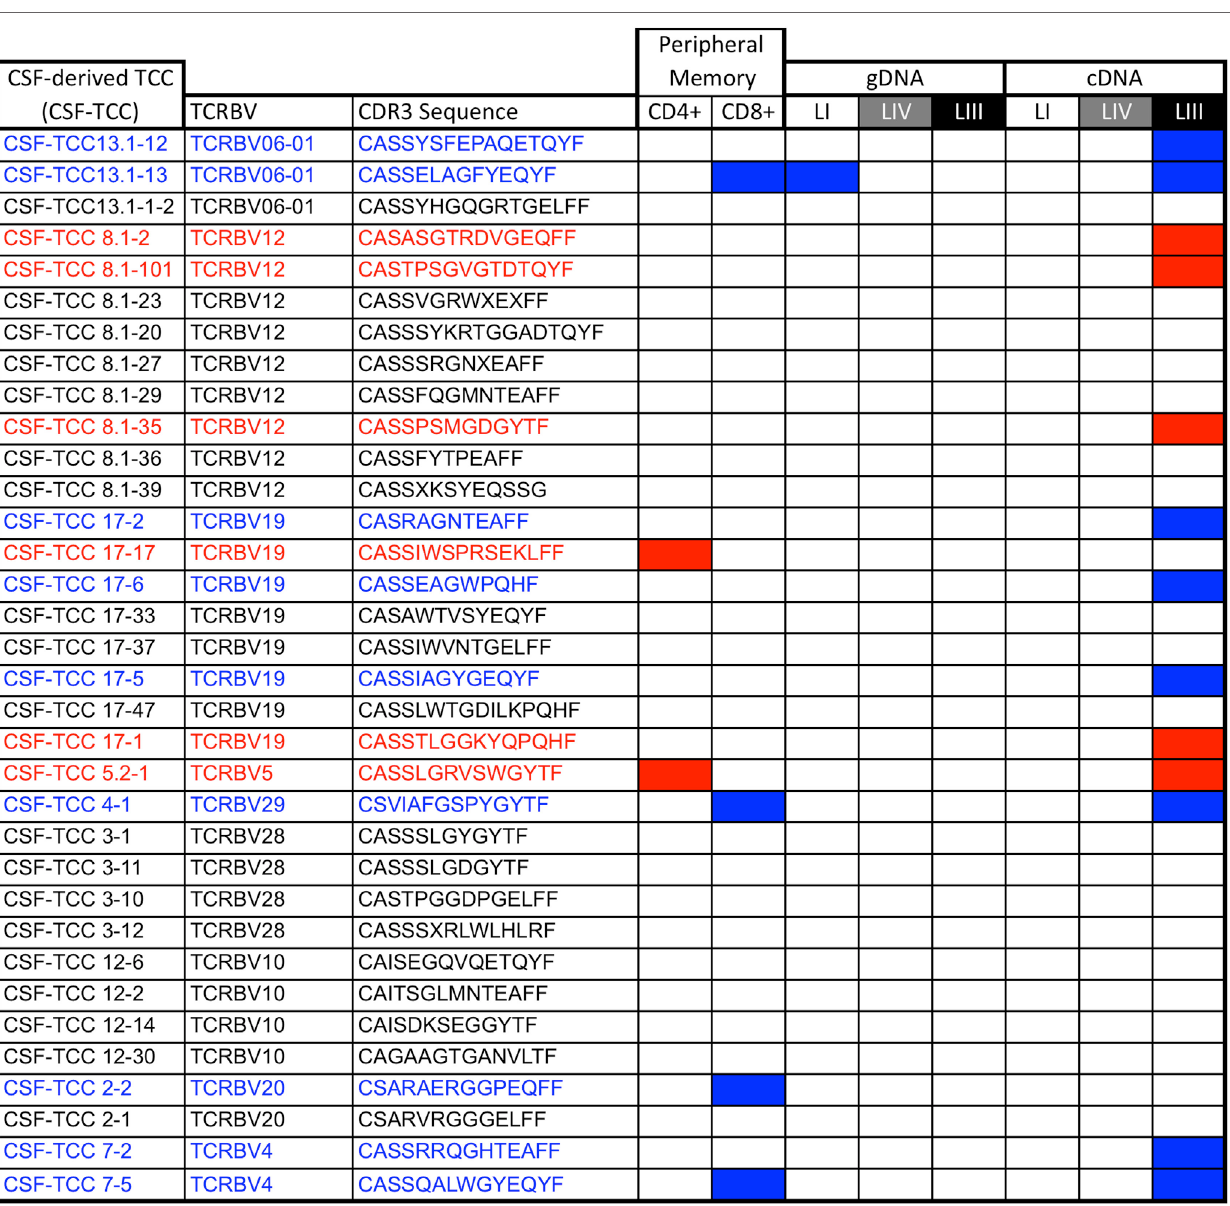
TaBle 3 | CSF-derived